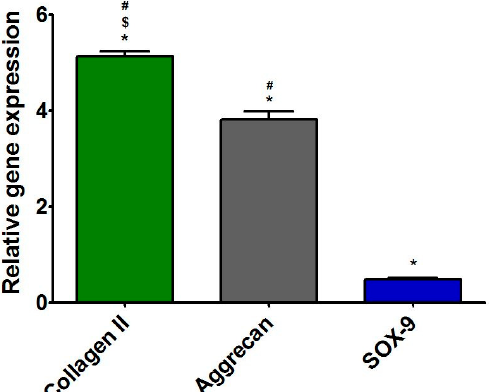
Figure 4. Relative expression level of genes: collagen II, aggrecan, and SOX-9 in freshly isolated chondrocytes. The results were normalized to the expression level of collagen I in isolated cells. * Significantly different results compared with expression level of collagen I; $ significantly different results compared with expression level of aggrecan; # significantly different results compared with expression level of SOX-9; one-way ANOVA test followed by Tukey’s multiple comparison, p < 0.05.